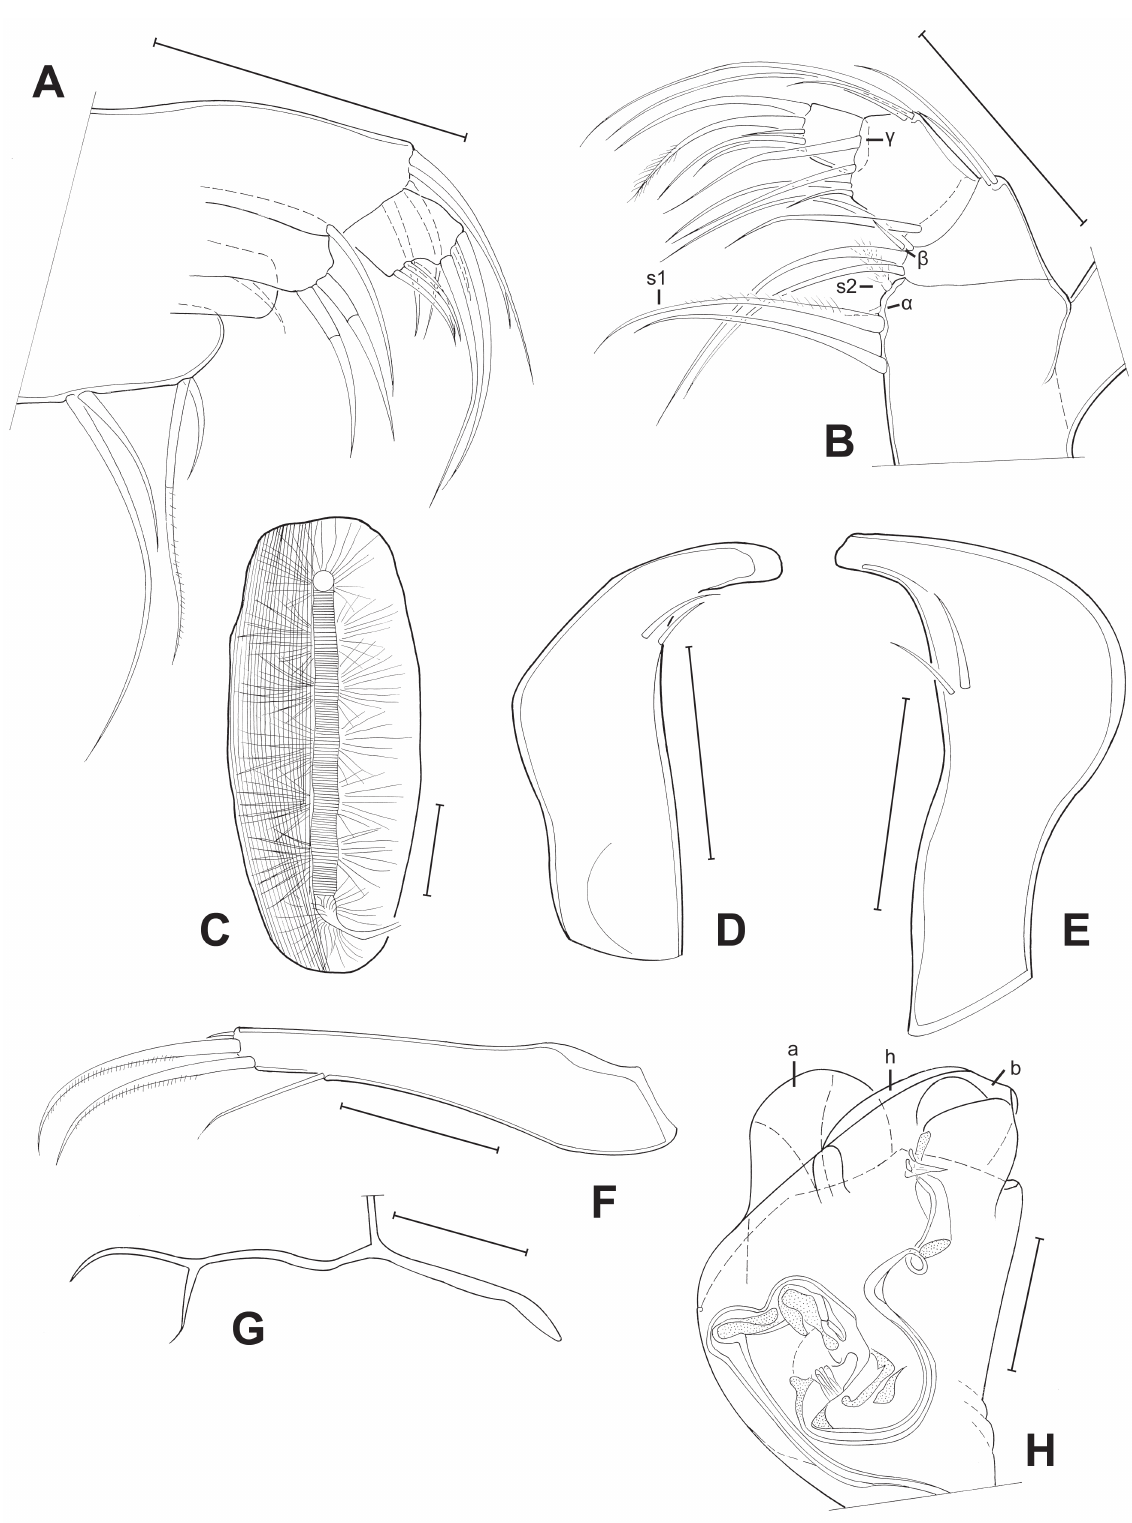
Fig. 4. Limbs of Pseudocandona agostinhoi sp. nov. (♂). A . Mx1 (MZUSP 32653). B . Md palp (MZUSP 32655). C . Zenker organ (MZUSP 32653). D . Right prehensile palp (MZUSP 32653). E . Left prehensile palp (MZUSP 32653). F . Caudal ramus (MZUSP 32653). G . Attachment of the caudal ramus (MZUSP 32653). H . Hemipenis (MZUSP 32653). Scale bars: A–H = 50 µ